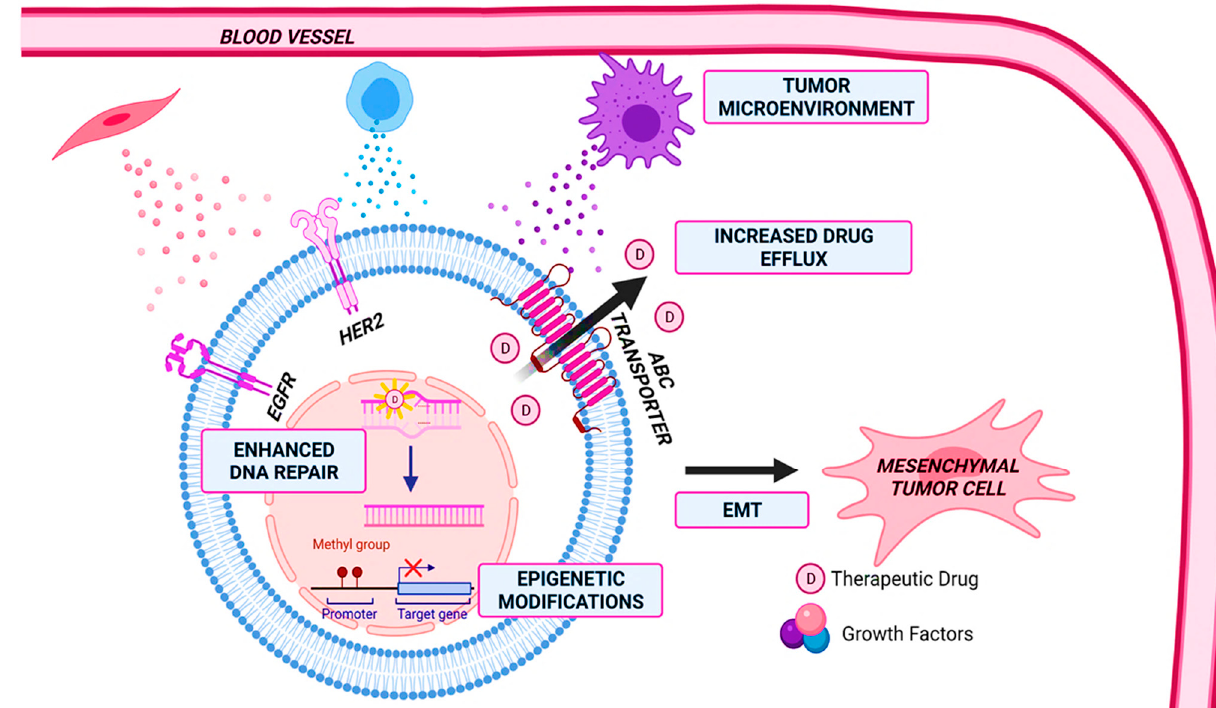
Figure 1. Mechanisms of drug resistance in breast cancer. These mechanisms include changes in the tumor microenvironment, enhanced DNA repair, epigenetic modifications, epithelial-to-mesenchymal transition (EMT), and increased drug efflux. Figure created with Biorender.com.